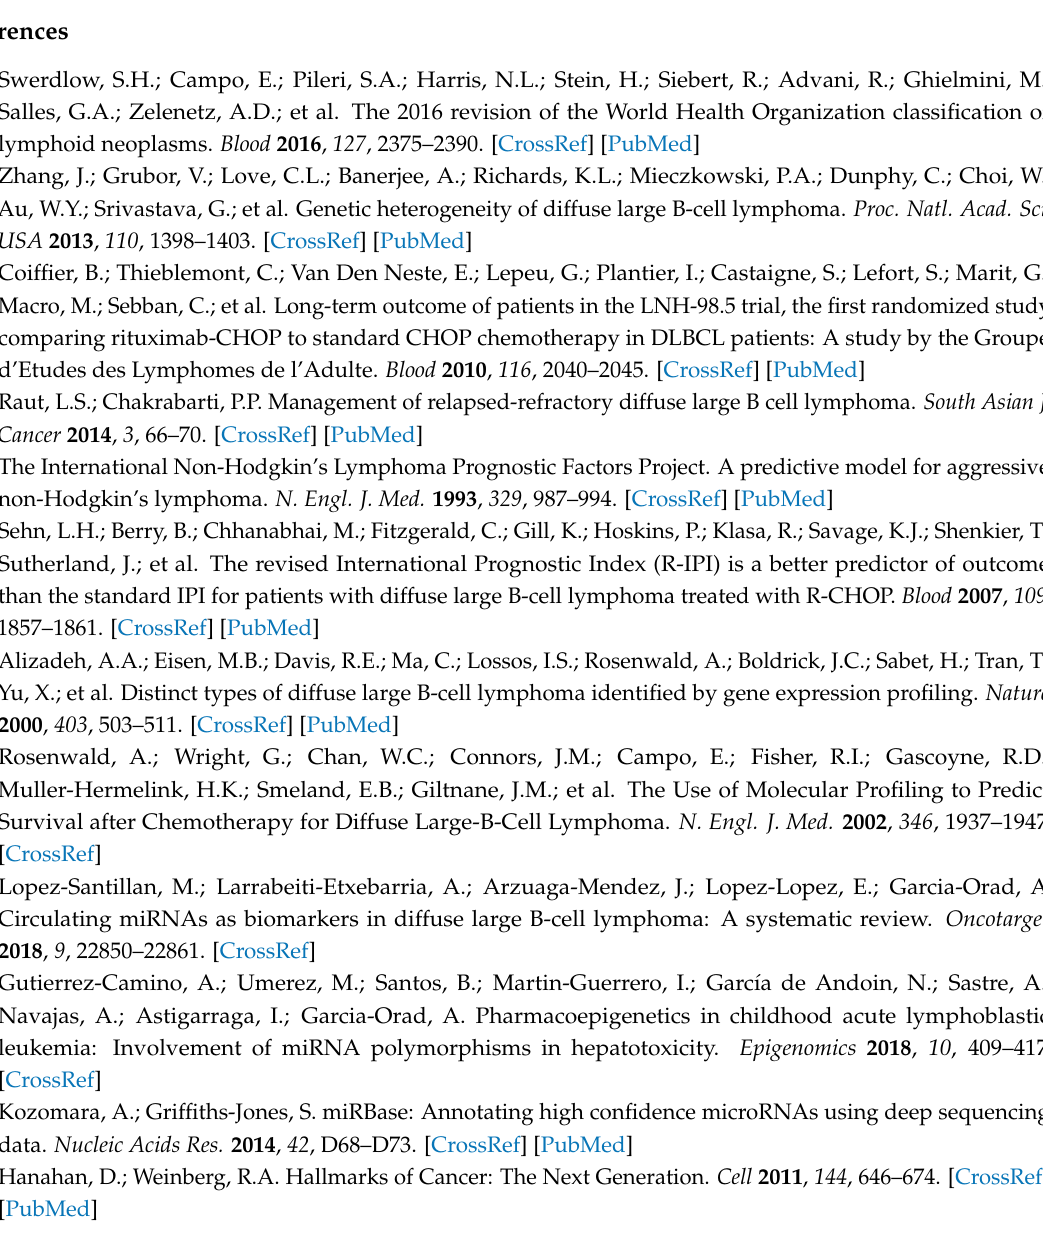
Table S1: Differentially expressed microRNAs in DLBCL patients compared with healthy control individuals, Table S2: Differentially expressed microRNAs in DLBCL subtypes, Table S3: Differentially expressed microRNAs as prediction to response to R-CHOP therapy, Table S4: Differentially expressed microRNAs as prognosis biomarkers, Table S5: Pathways significantly enriched among hsa-miR-155-5p and hsa-miR-21-5p (DLBCL diagnosis) target genes predicted by 6 or more databases, Table S6: Pathways significantly enriched among hsa-miR-155-5p, hsa-miR-221-3p (DLBCL subtype) target genes predicted by 6 or more databases. Author Contributions: E.L.-L. and A.G.-O. contributed to the conception and design of the study. A.L.-E., B.S.-Z. and M.L.-S., acquired and analyzed the data. A.L.-E., B.S.-Z., E.L.-L. and A.G.-O. interpreted the results and drafted the article. E.L.-L and A.G.-O. acquired and administrated the funding. All authors have read, reviewed critically and approved the final